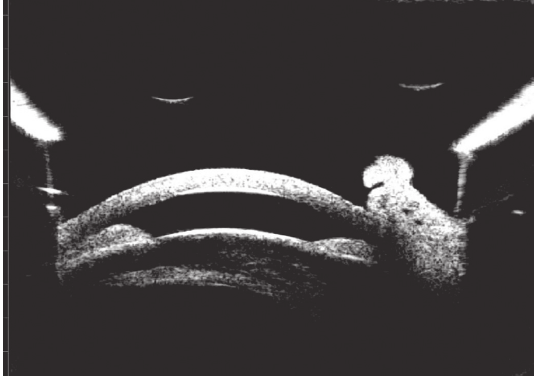
Figure 4: Preoperative ultrasound biomicroscopic image of a patient with acute angle